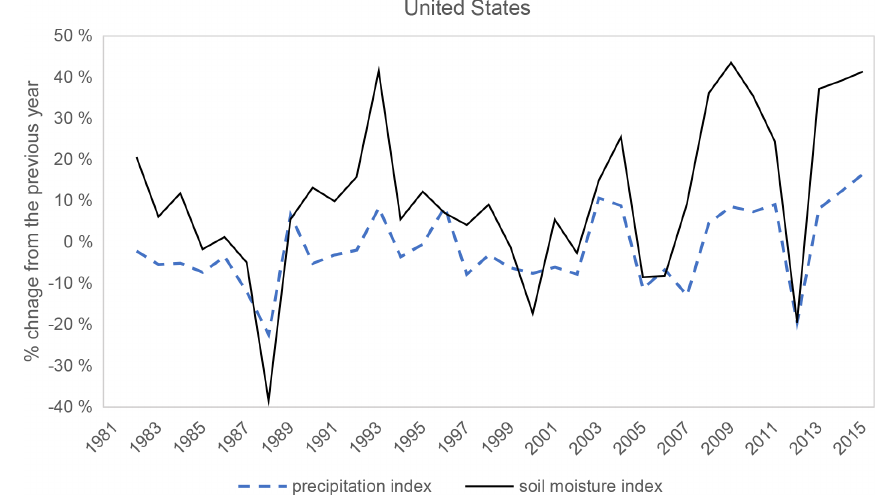
Figure 3. Variations in average precipitation versus average soil moisture over corn areas in the United States. The precipitation is aggregated from PRISM, and soil moisture is aggregated from WBM from 2.5arcmin grid cells weighted by cropland area.